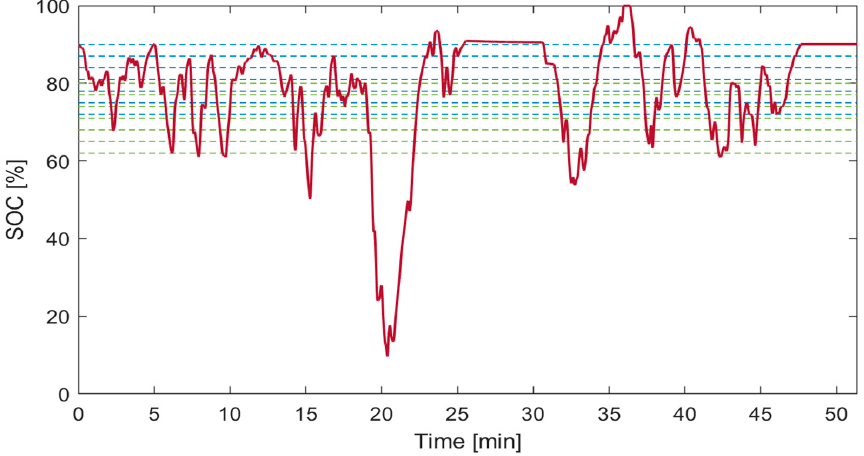
Figure 7. Flywheel energy storage system (FESS) bench state of charge.